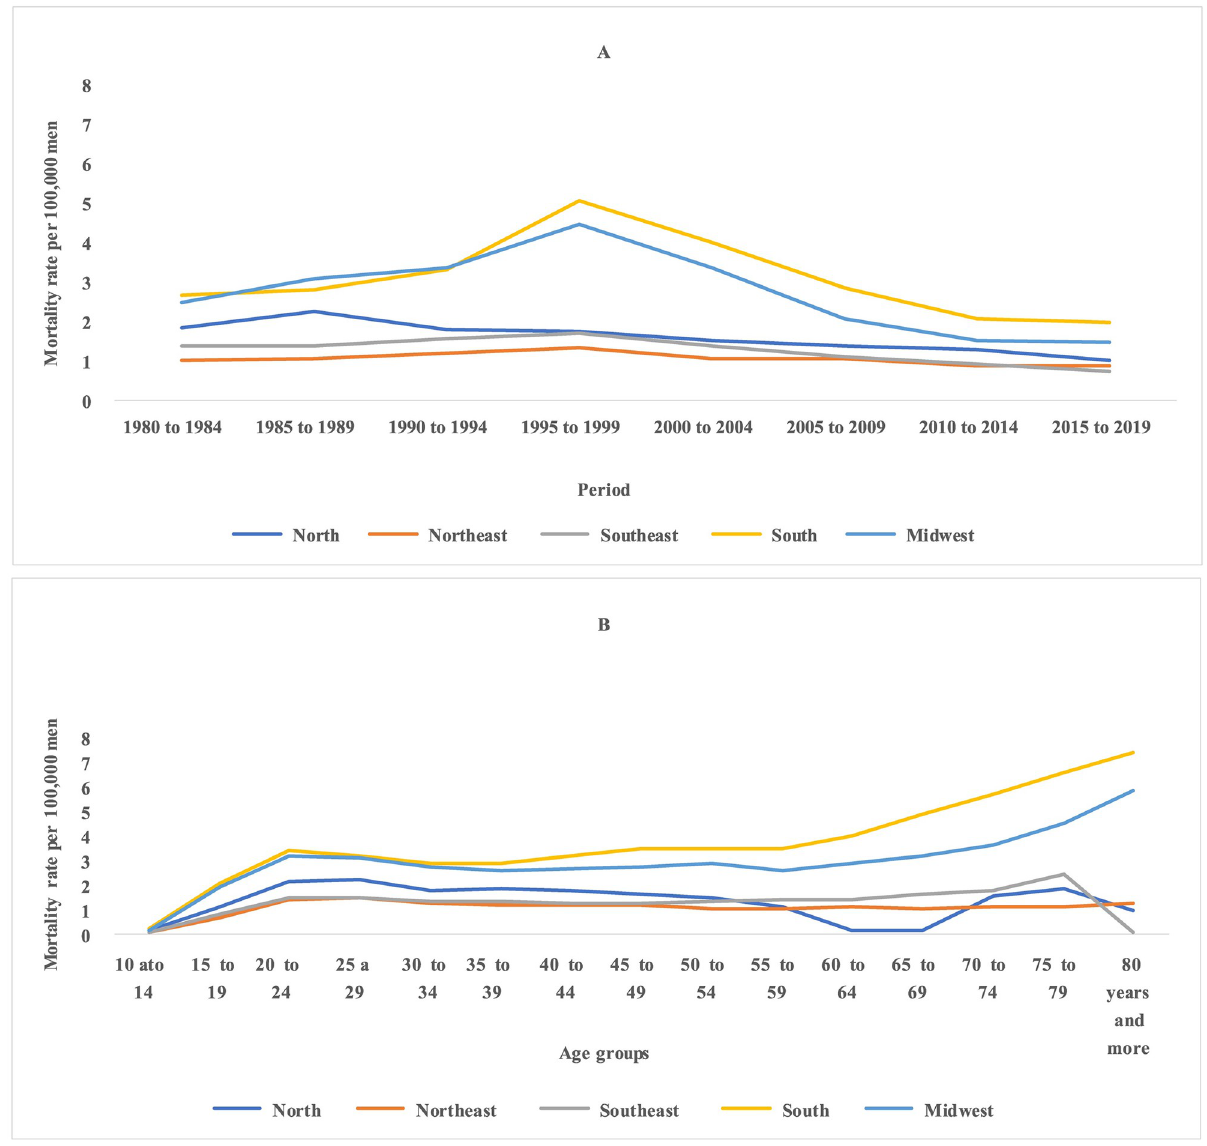
Fig 4. Suicide by firearms mortality rates per 100,000 men in in major Brazilian regions according to age, period, and cohort, from 1980 to